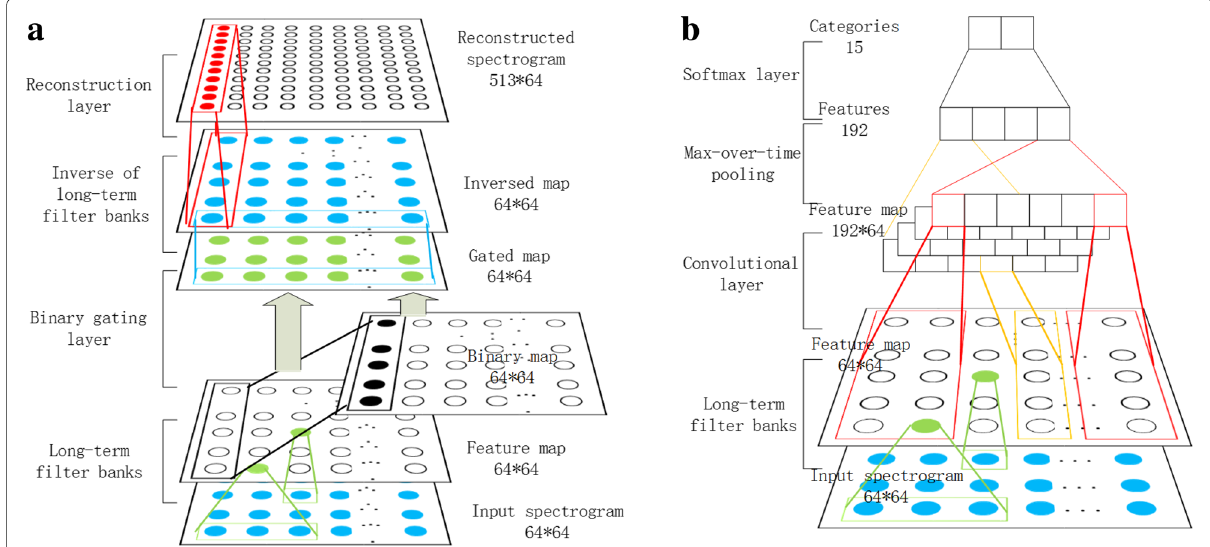
Fig. 5 NN-based structures with proposed method. a The NN structure for audio source separation task. b The NN structure for audio scene classification